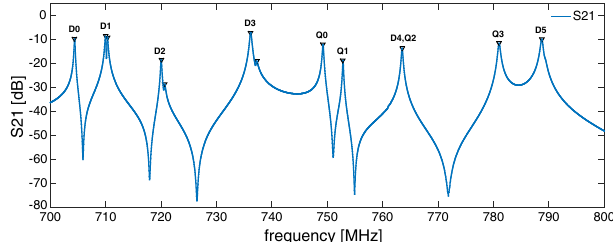
FIG. 8. Measurement of Mode spectra of the fully assembled RFQ. The different dipole (D) and quadrupole (Q) modes are indicated.